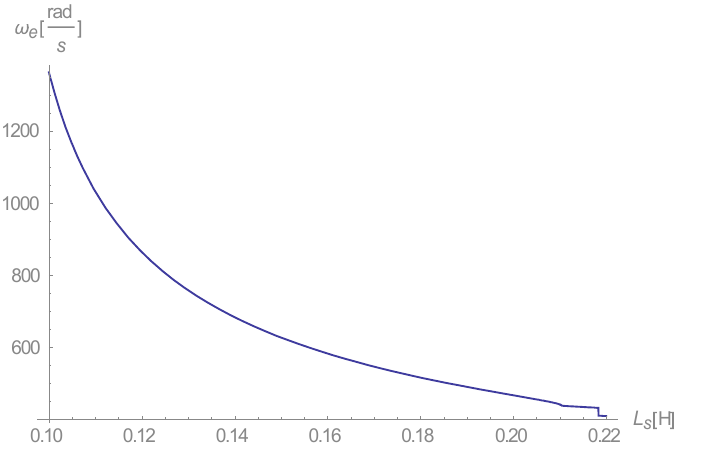
Figure 6. Plot of the real part of the second solution of ω (cid:2915) (L S ).